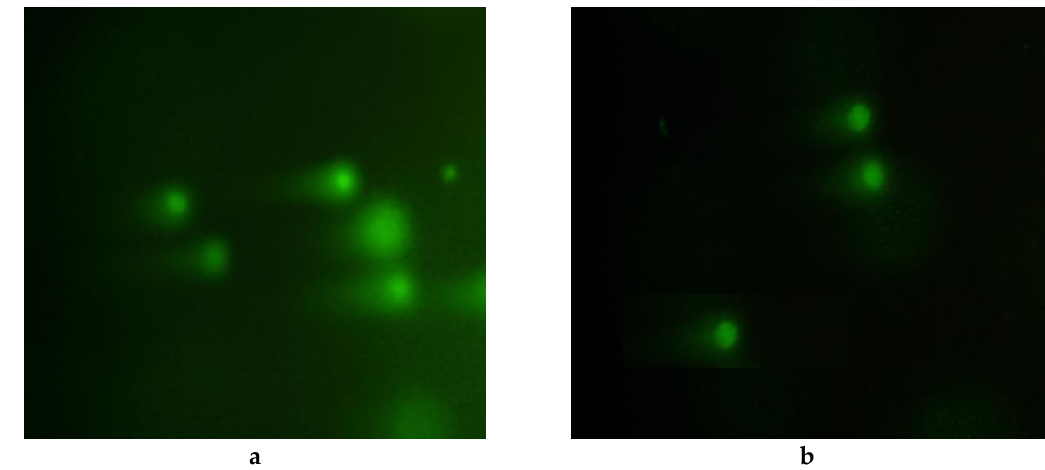
Figure 7. DNA damage in blood cells of F. multistriata tadpoles treated with M. aeruginosa : M. aeruginosa ( a ) treated by P. chrysosporium ( b ). Table 2. DNA damage induced by M. aeruginosa ( a ) treated by P. chrysosporium ( b ) to blood cells of F. multistriata tadpoles detected by Comet assay. Time (h)